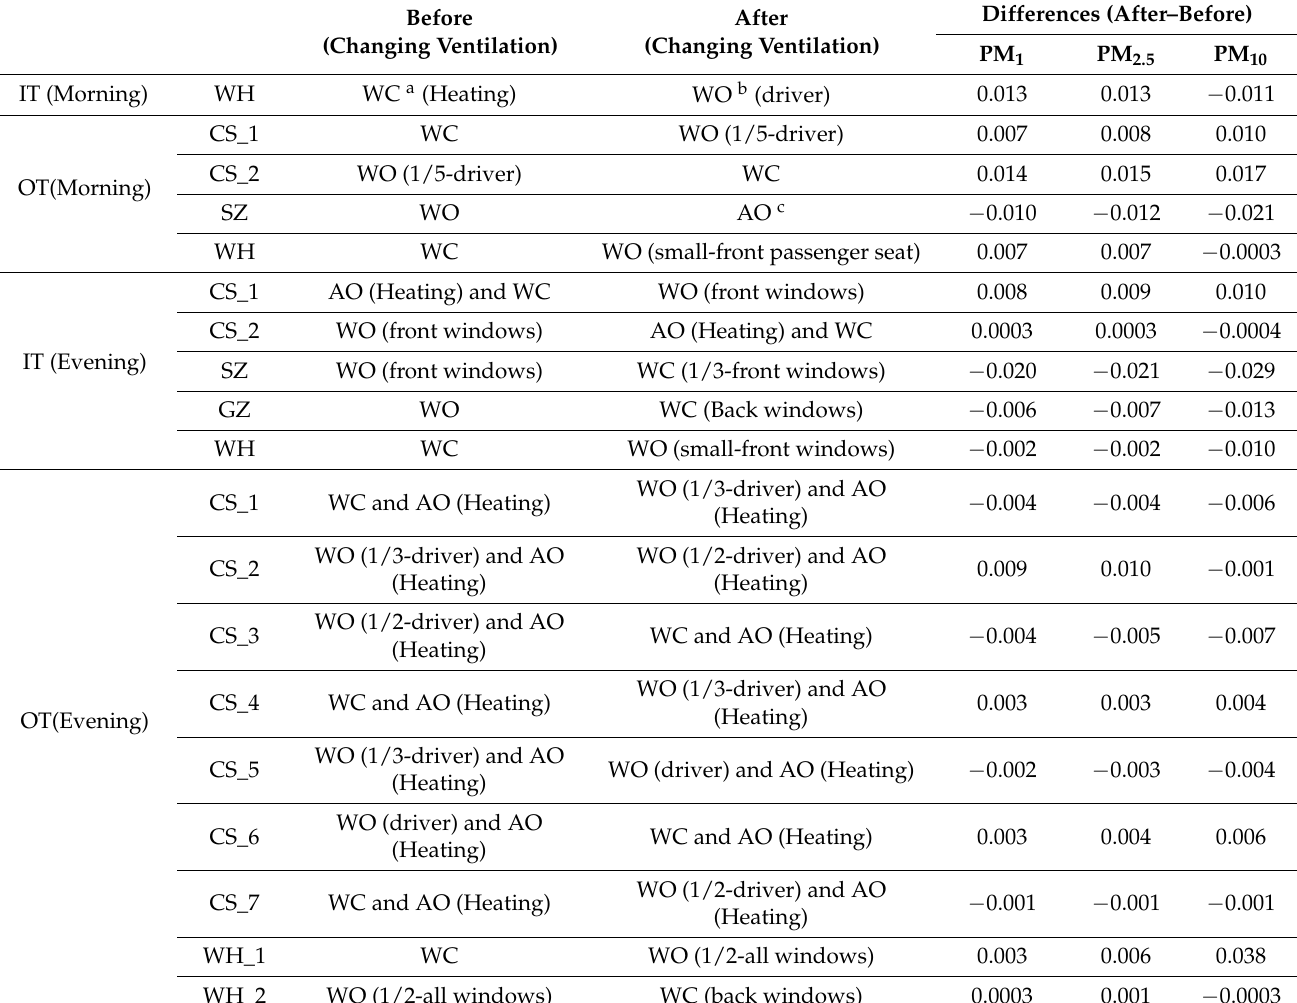
Table 4. Description of ventilation conditions before and after the changes when commuting in a